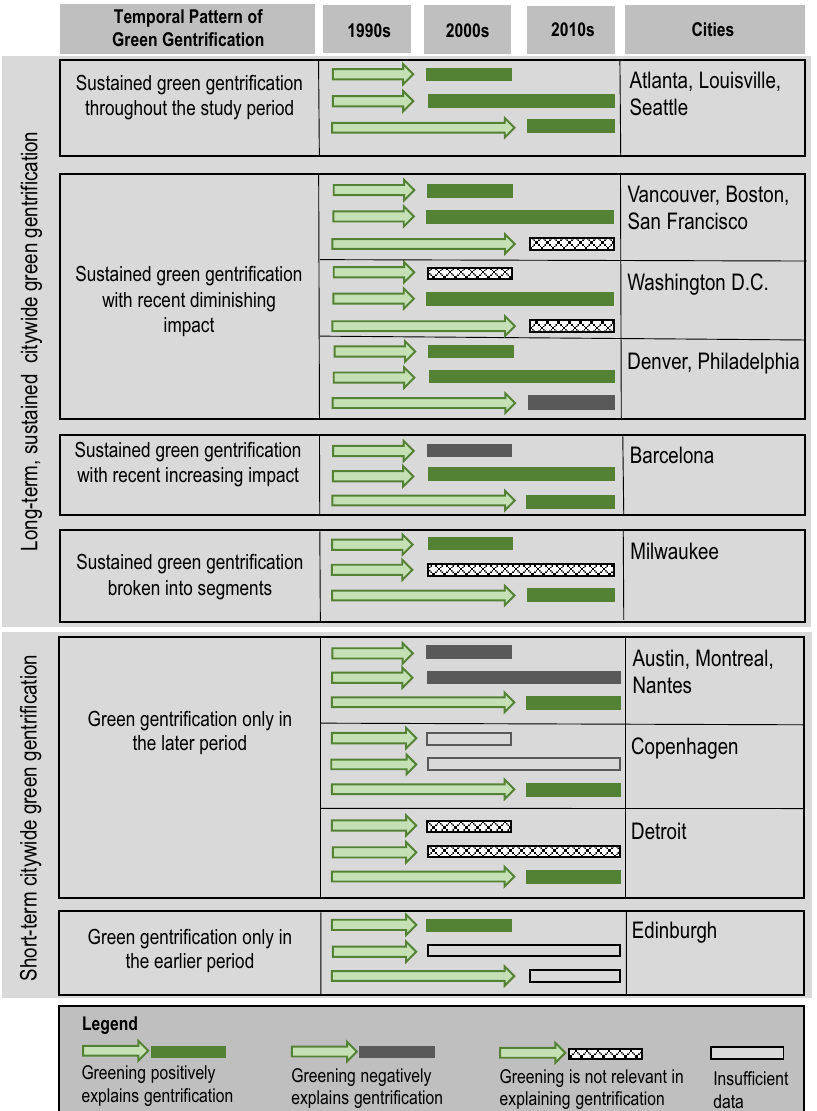
Fig. 2 Cities with patterns of green gentri fi cation. These patterns show green gentri fi cation trends over time in the 17 cities where greening from an earlier period is a likely relevant variable in positively explaining gentri fi cation in the period(s) immediately following at some point between 1990 and 2016. There are two temporal groups: long-term (2 decades) and short-term